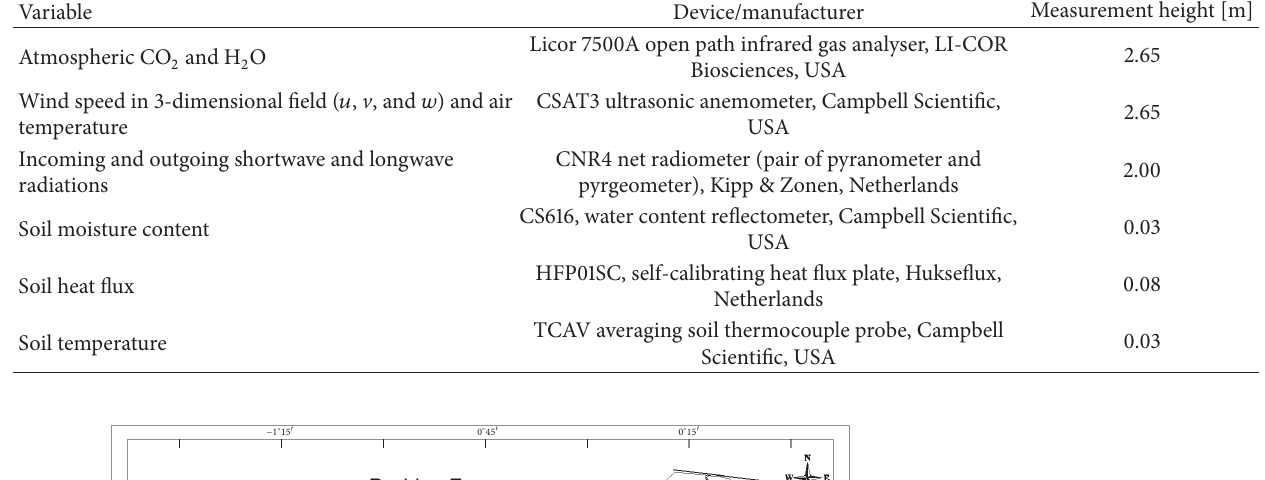
Table 1: Summary of measurement heights of selected data used for SOLVEG simulations.